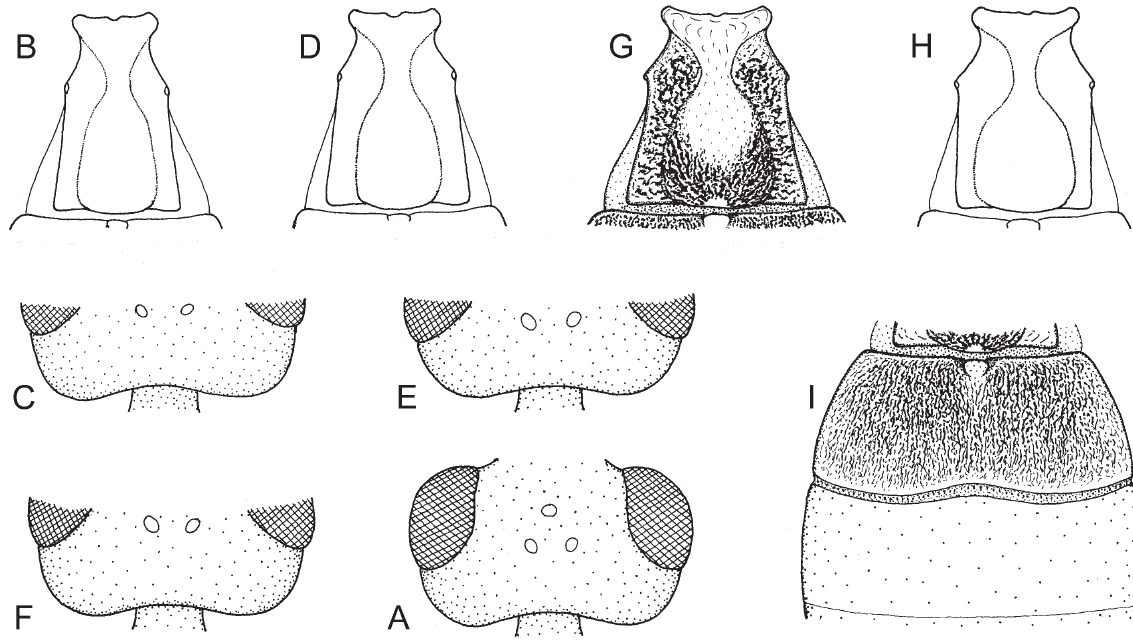
Fig. 38. Bracon ( Glabrobracon ) picticornis Wesmael, 1838 (A, E-F, H: ♀ / ♂, B: ♀ paralectotype, C -D: ♂ paralectotype, G, I: ♀). A . Head in dorsal view. B . First tergite. C . Hind half of head in dorsal view. D . First tergite. E-F . Hind half of head in dorsal view. G-H . First tergite. I . Tergites